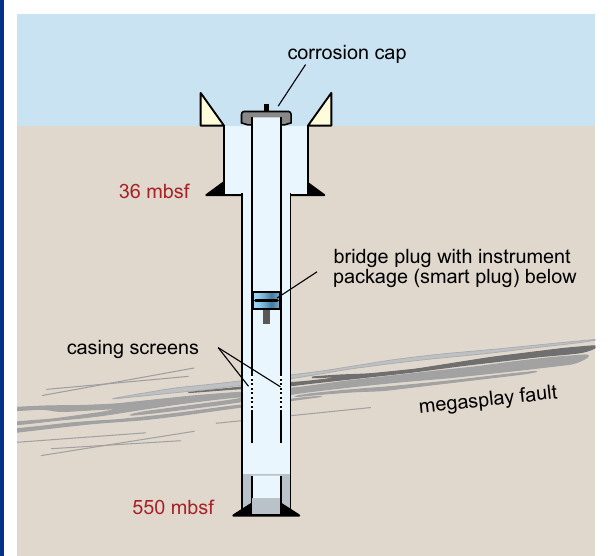
Figure 8. Diagram of smart plug observatory to monitor pressure and temperature changes within the megasplay fault zone at Site C0010.